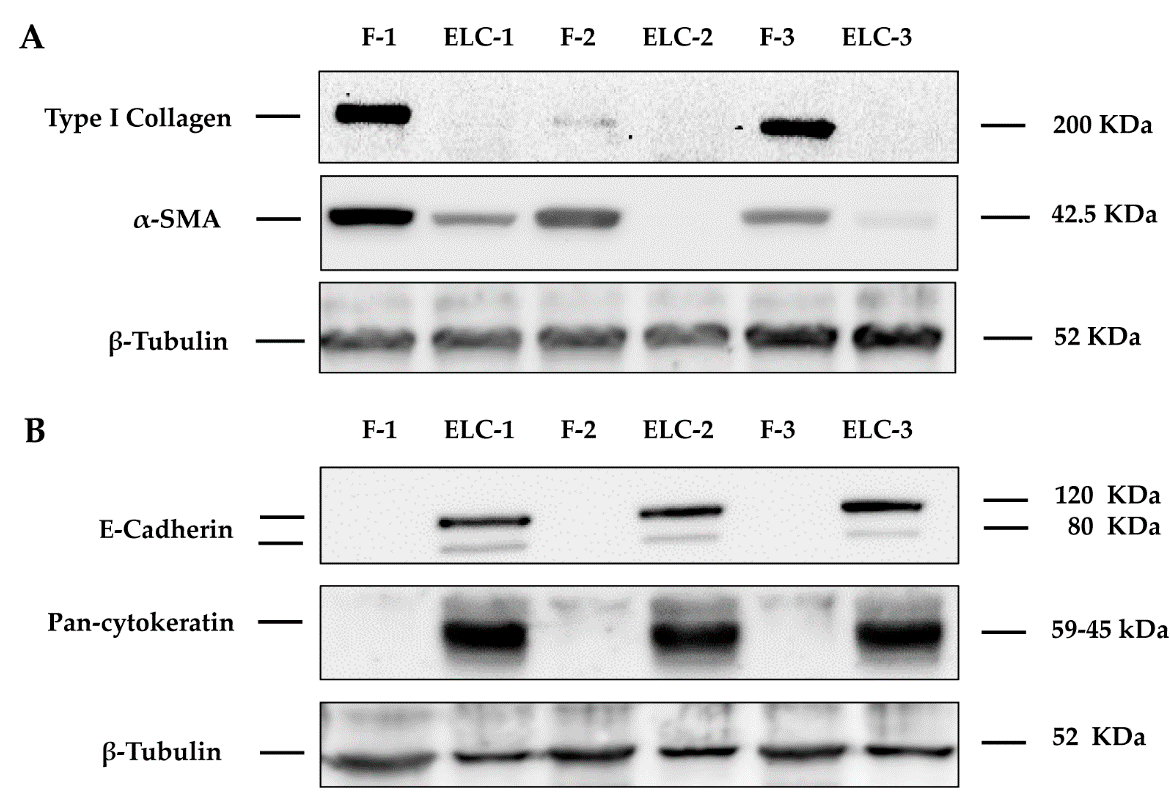
Figure 2. Human lung fibroblast when converted in ELC downregulated α -SMA and collagen type I, and concomitantly upregulated E-cadherin and cytokeratins. The expression of fibroblast and epithelial biomarkers analyzed by Western blotting showed that the change from a spindle to a polygonal/cobblestone shape was consistent with the marked downregulation of α -SMA and collagen type I ( A ), and the overexpression of E-cadherin, pancytokeratin (4, 5, 6, 8, 10, and 13 cytokeratin) ( B ). Three different cell lines were analyzed: two from ILD patients (lines F1/ELC-1; F-2/ELC-2), and two from brain dead patients (F-3/ELC-3; F3/ELC3). β -tubulin was used as a loading control. F: fibroblast; ELC: epithelial-like cell.